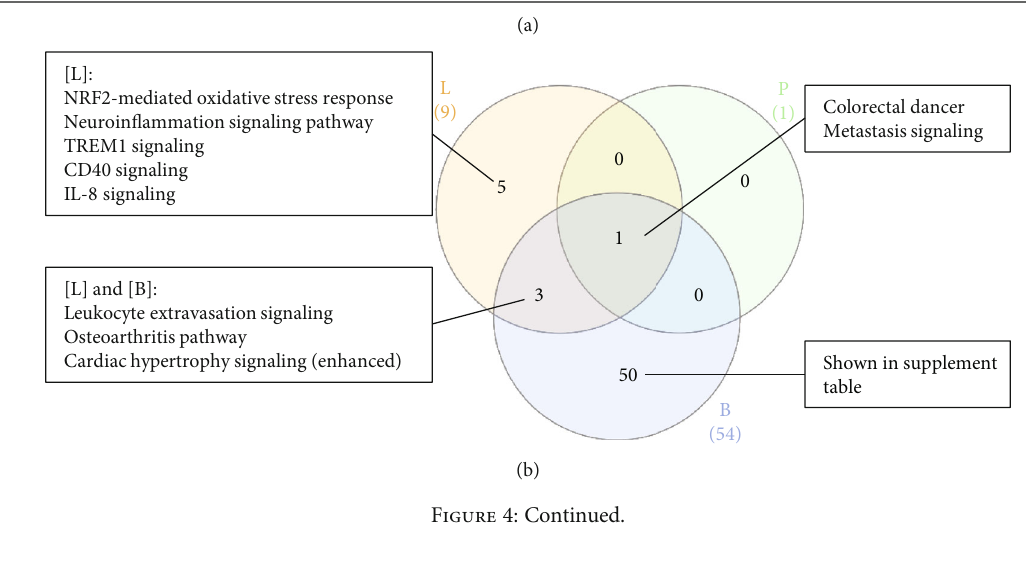
Colorectal dancer Metastasis signaling